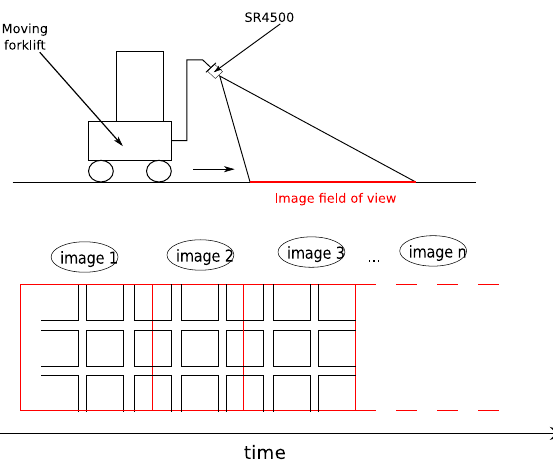
Figure 16. Picture of the surface of interest